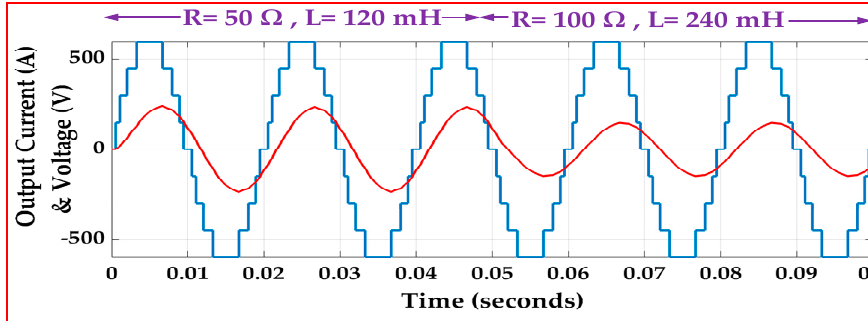
Figure 11. Dynamic inductive load change.